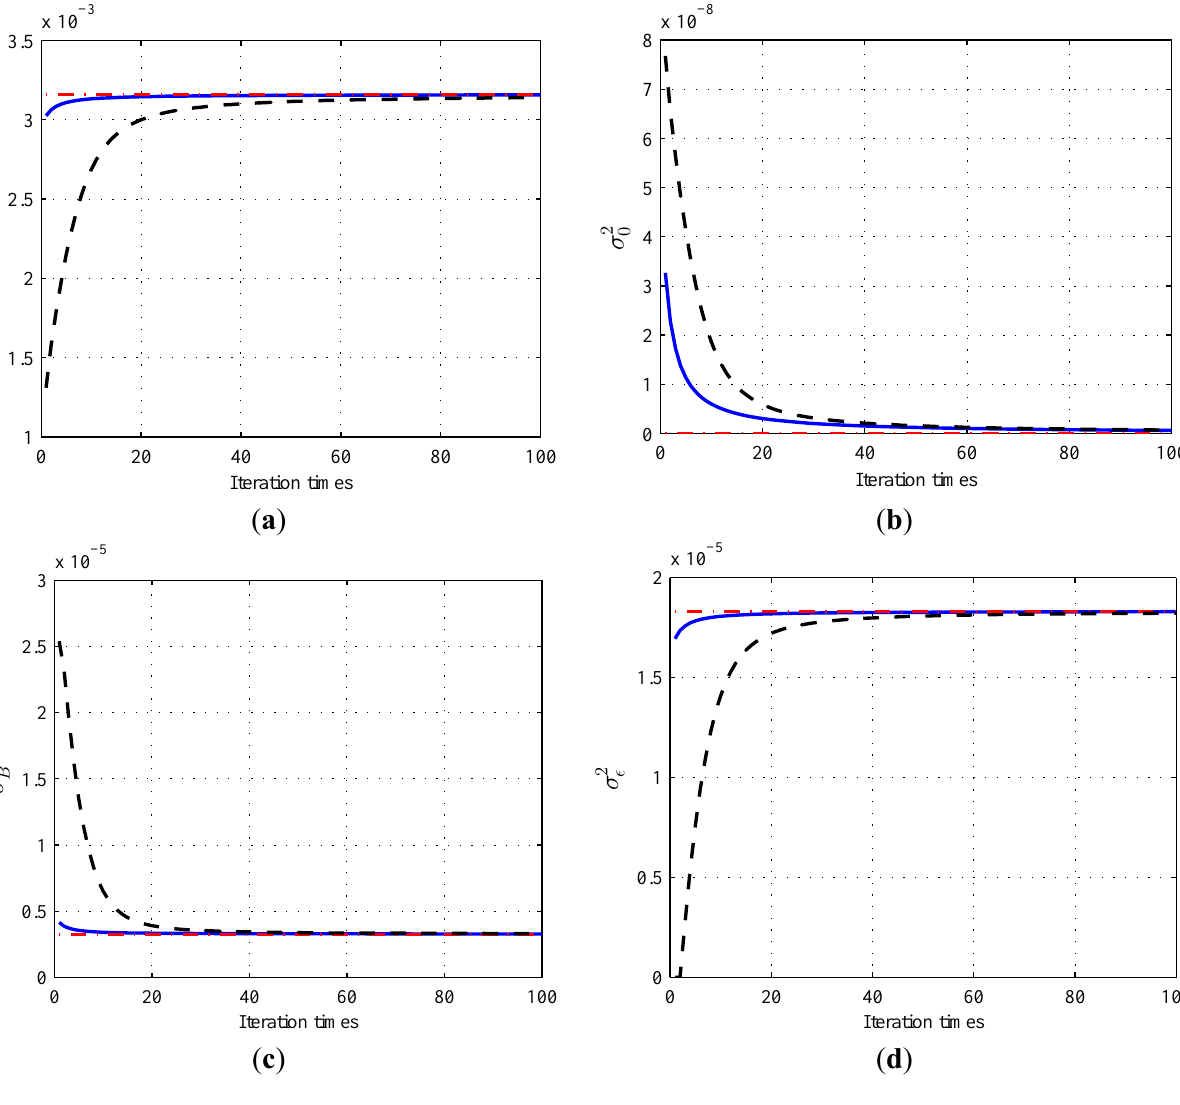
Figure 4. The estimated parameters by the expectation maximization (EM) algorithm: μ ; ( b ) 2 σ ; ( c ) 2 σ ; and ( d ) 2 σ (real prior parameters: blue solid line; random prior ( a ) 0 B 0 ε parameters: black dotted line; the result of the MLE: red dashed